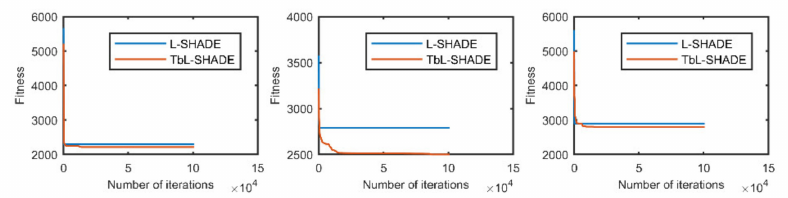
Figure 7. The selected average convergence of L-SHADE and TbL-SHADE is compared on CEC2020 in 15 D . From left to right f8, f9 and